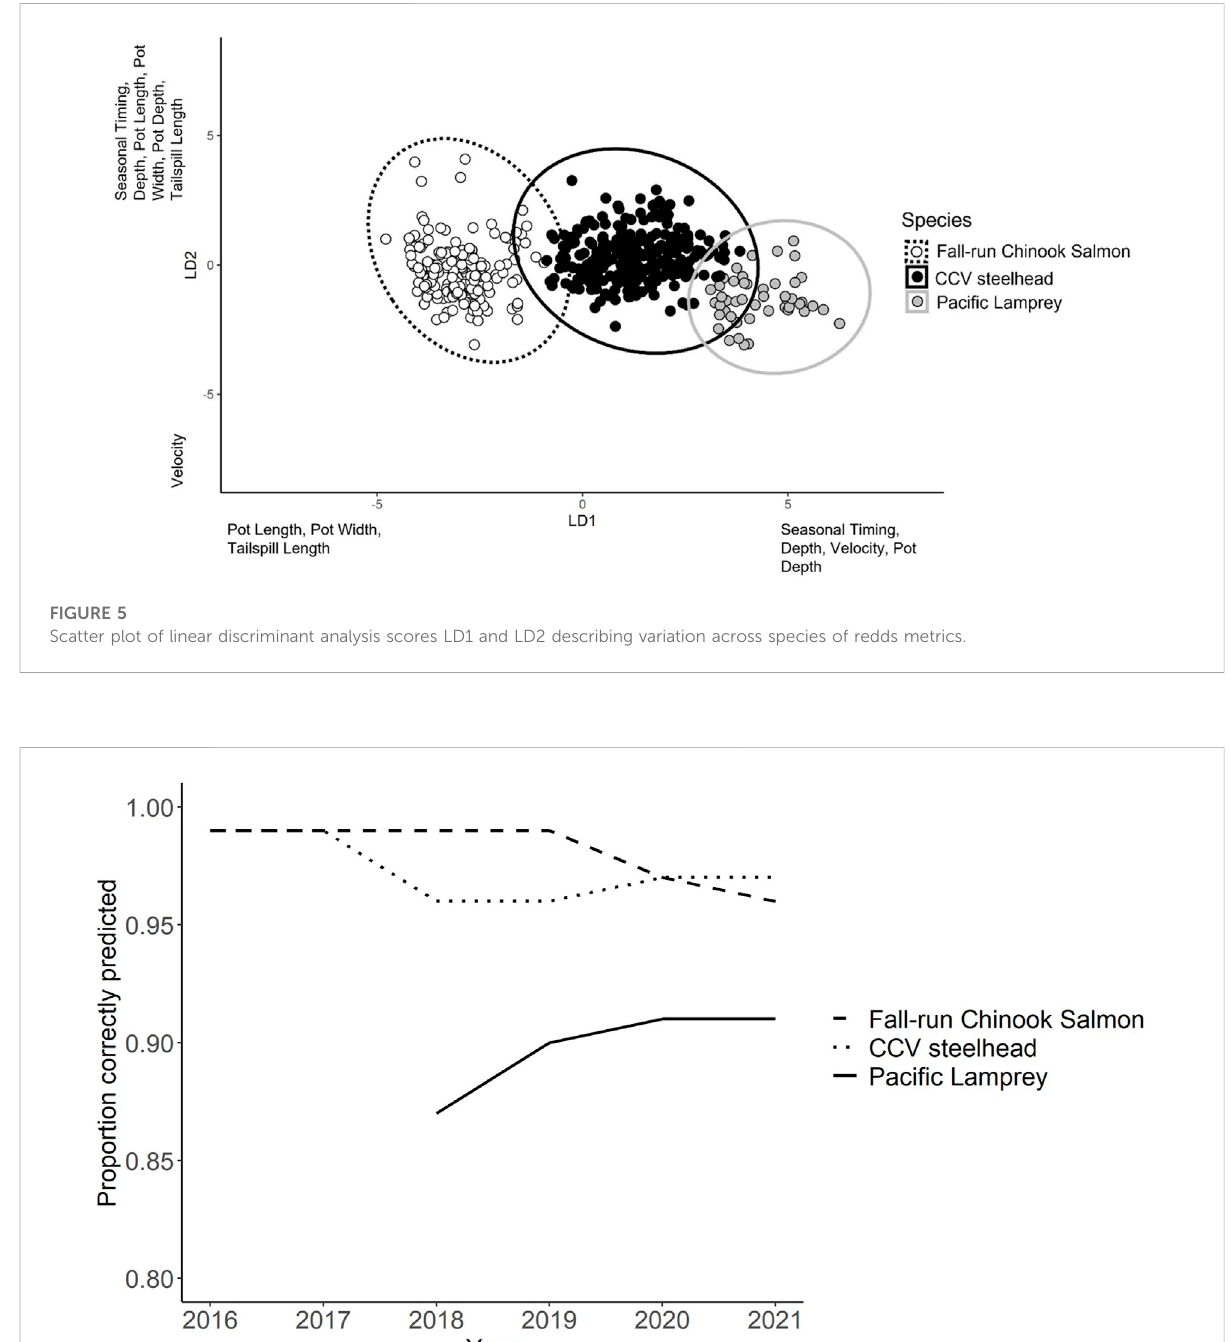
(population peak number redds observed on 28 March) or had a tailspill lengths and/or pot widths greater than 100 cm (mean = 56.8 cm and 52.7 cm, respectively). Several CCV